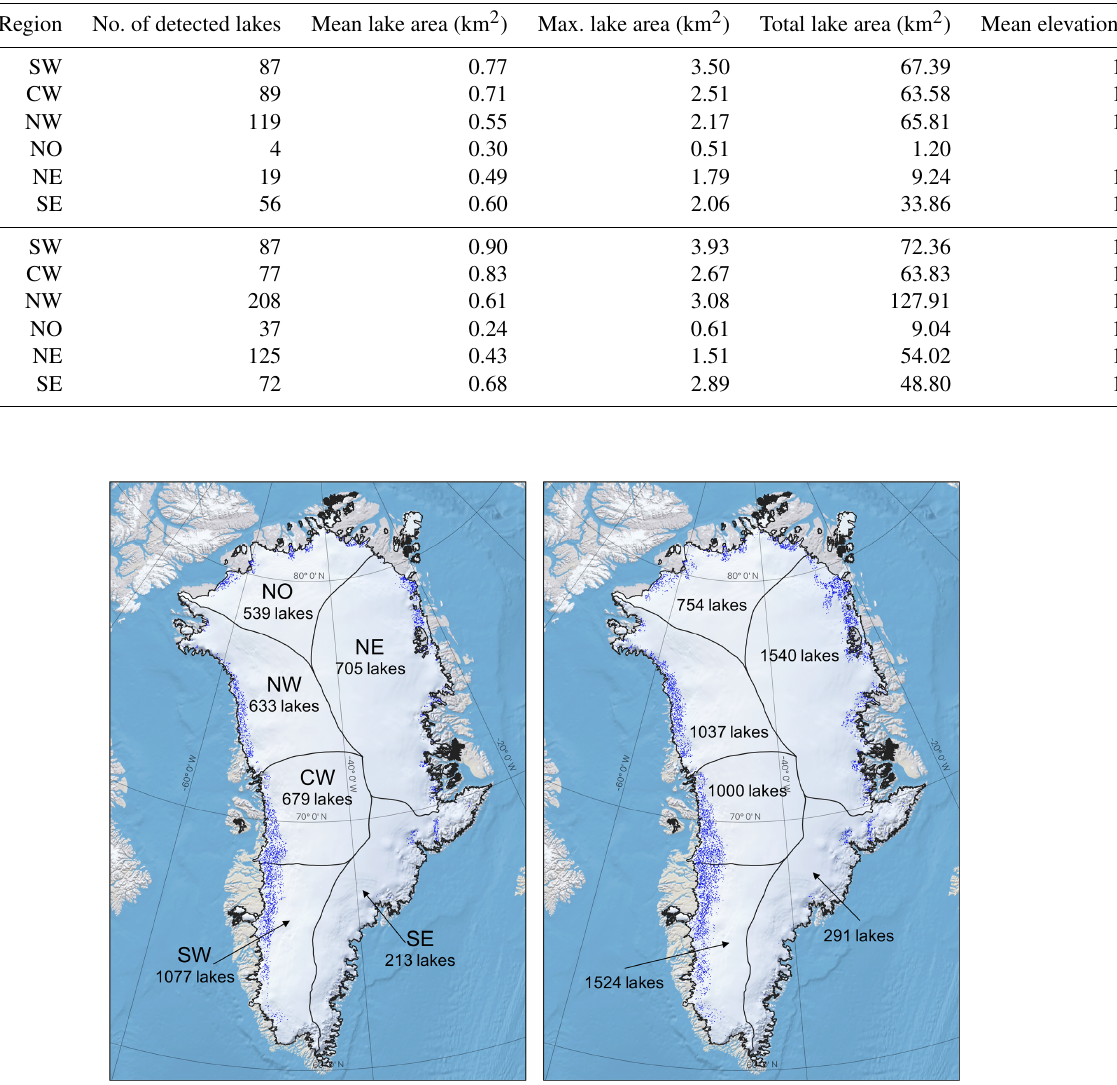
Figure B1. Surface lake distributions, shown in blue. (a) The 2018 detected surface lakes with major GrIS drainage basins labelled (Rignot and Mouginot, 2012). (b) The 2019 detected surface lakes. The background map is from GEE (Gorelick et al.,